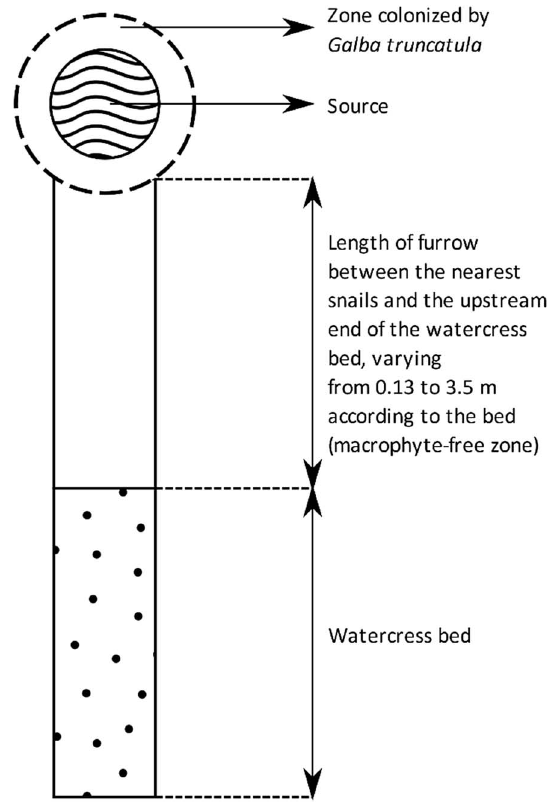
Figure 1. Schematic representation of the upstream end of a surface drainage furrow studied. This drawing shows the area occupied by the snails around the source, the area without macrophytes, of variable extent depending on the furrow, and the watercress bed located further downstream. The dimensions of these various zones have not been indicated on this drawing because they vary according to the type of bed and the length of the zone without